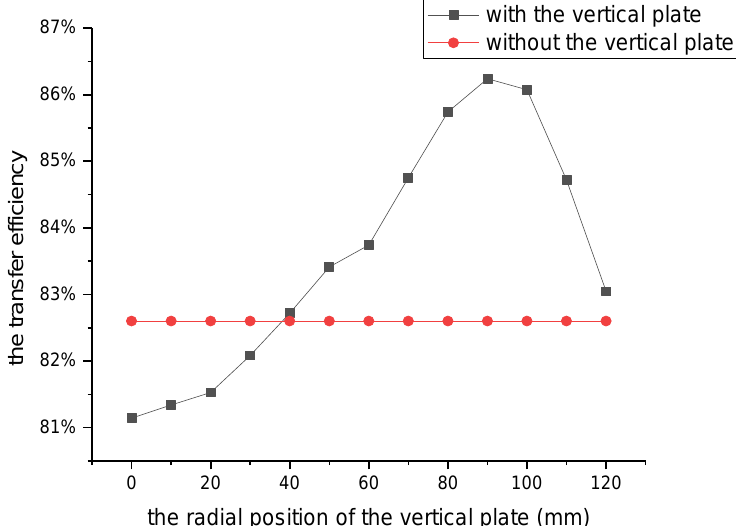
Figure 11. Experimental results of the variation of the efficiency with the axial position of the parallel plates.